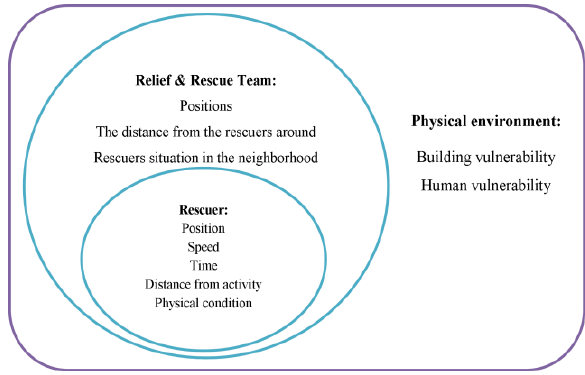
Figure 1. Three components of context in relief &